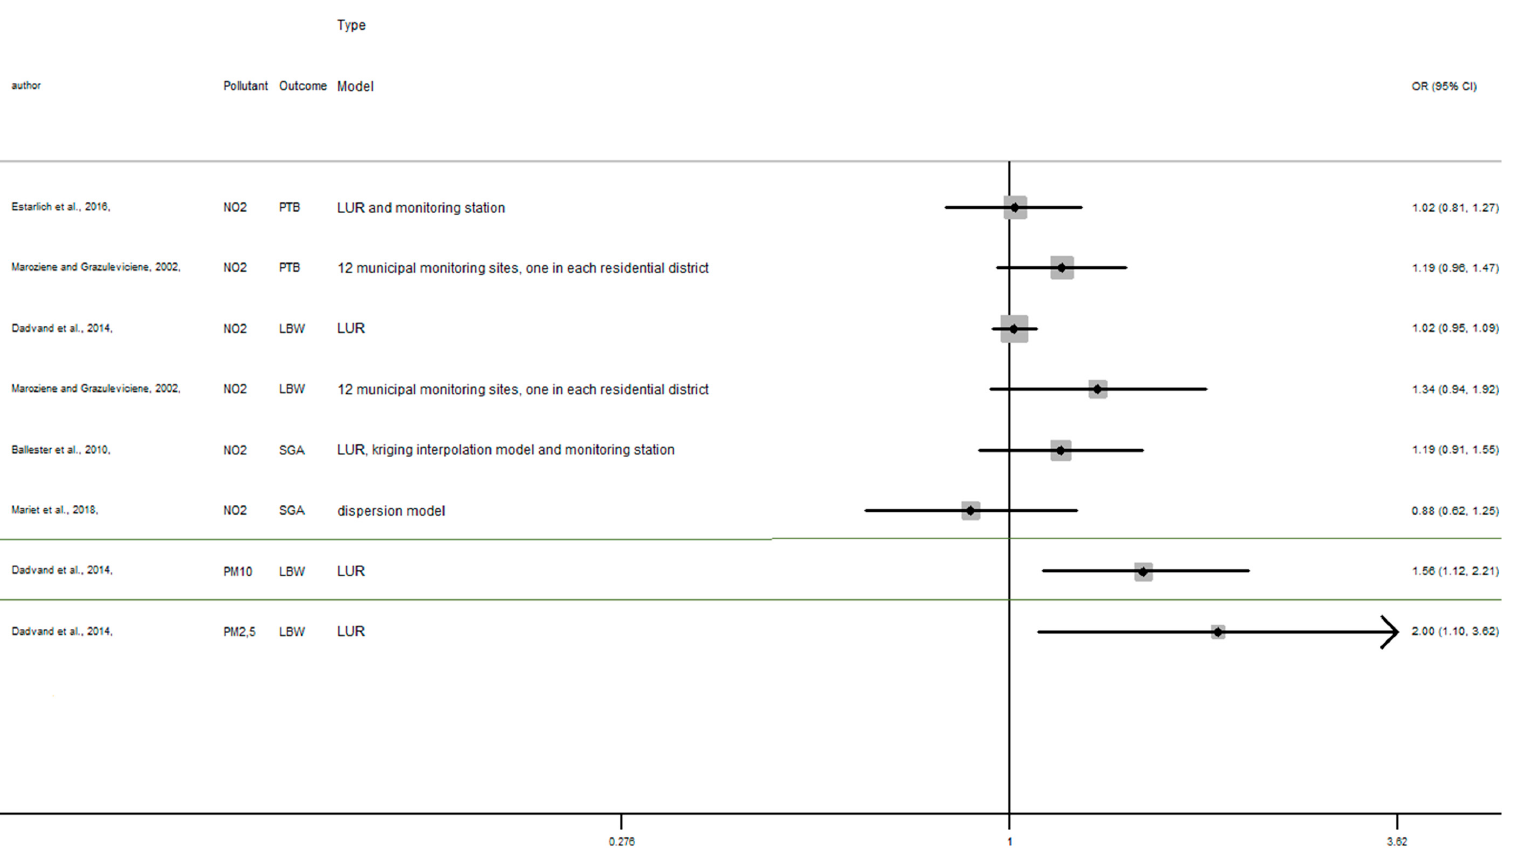
Figure A4. Risk of birth outcome for air pollutant exposure during third trimester.